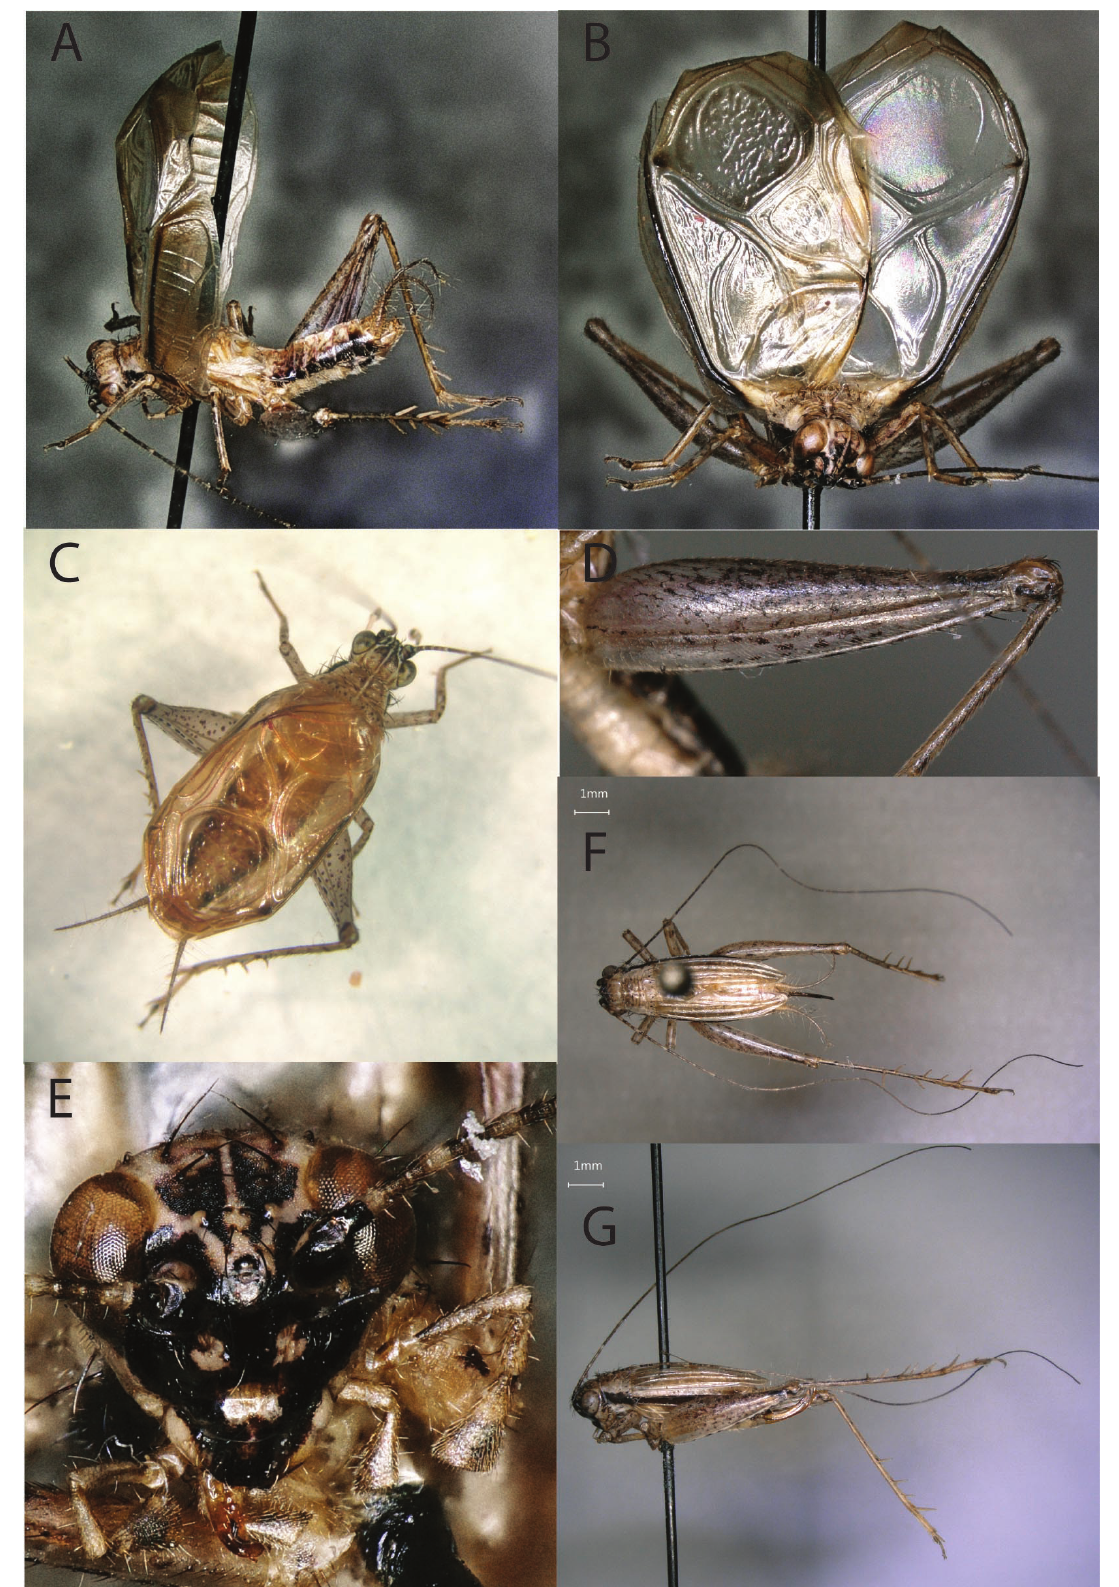
Fig. 1. A. Holotype male, dorsolateral view; B. Holotype male, anterior view; C. Paratype male, living habitus; D . Holotype male, left hind femur; E. Holotype male, face; F. Paratype female, dorsal view; G. Paratype female, lateral